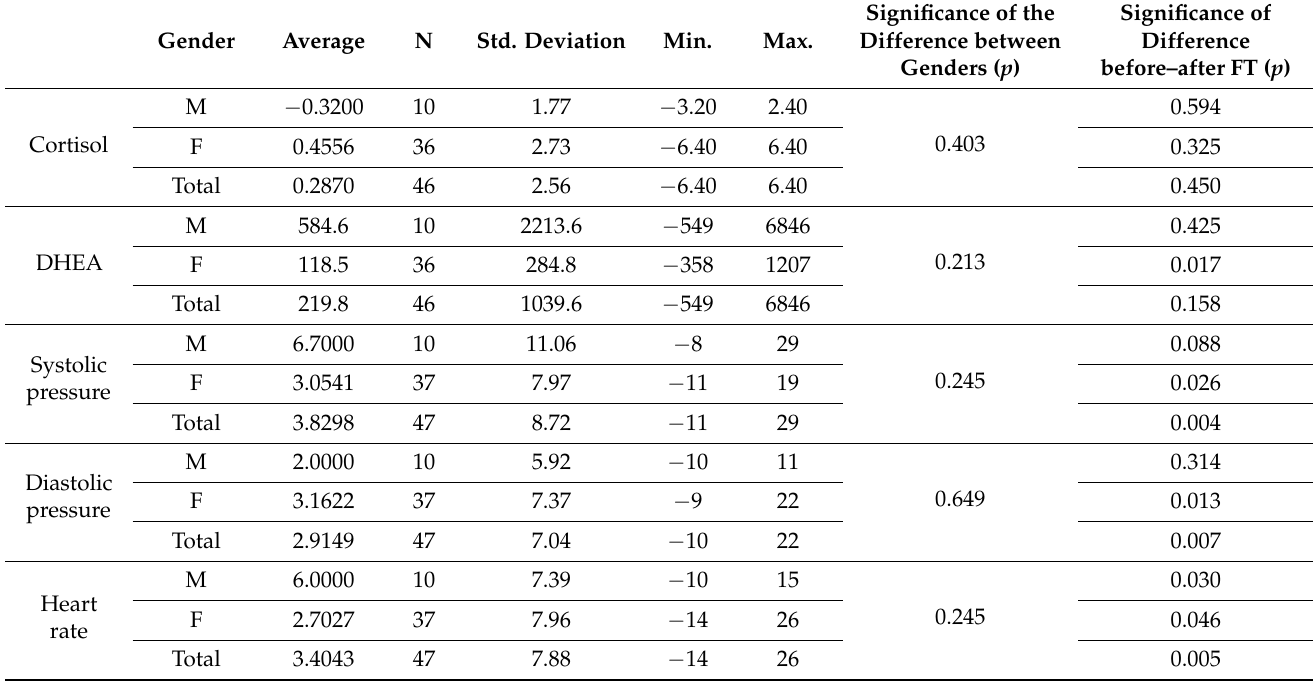
Table 3. Differences in average values of measurements of physiological parameters before and after forest